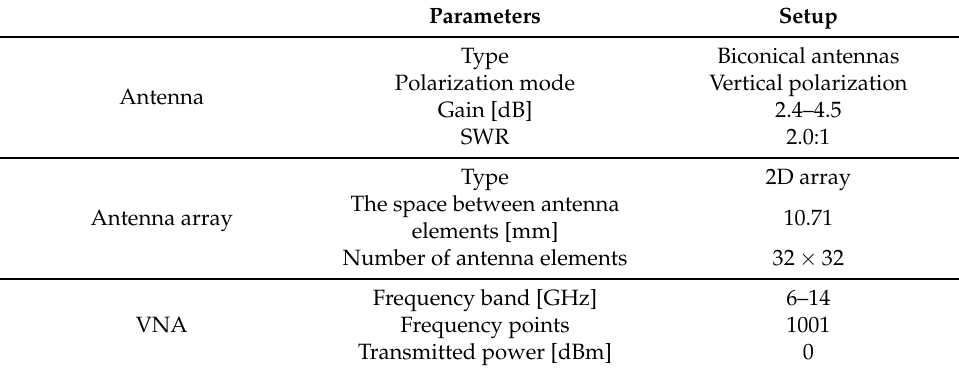
Table 1. Measurement setup and specifications.